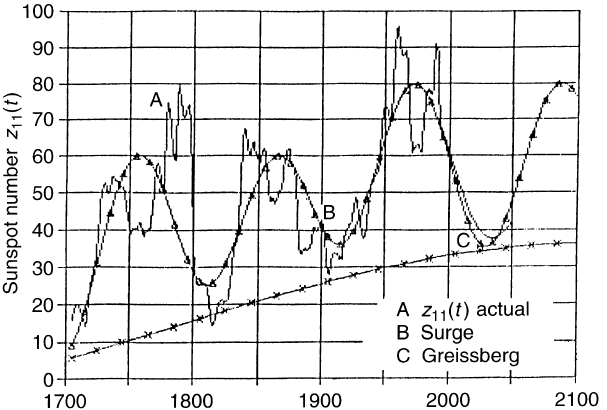
Fig. 2. Collective surging